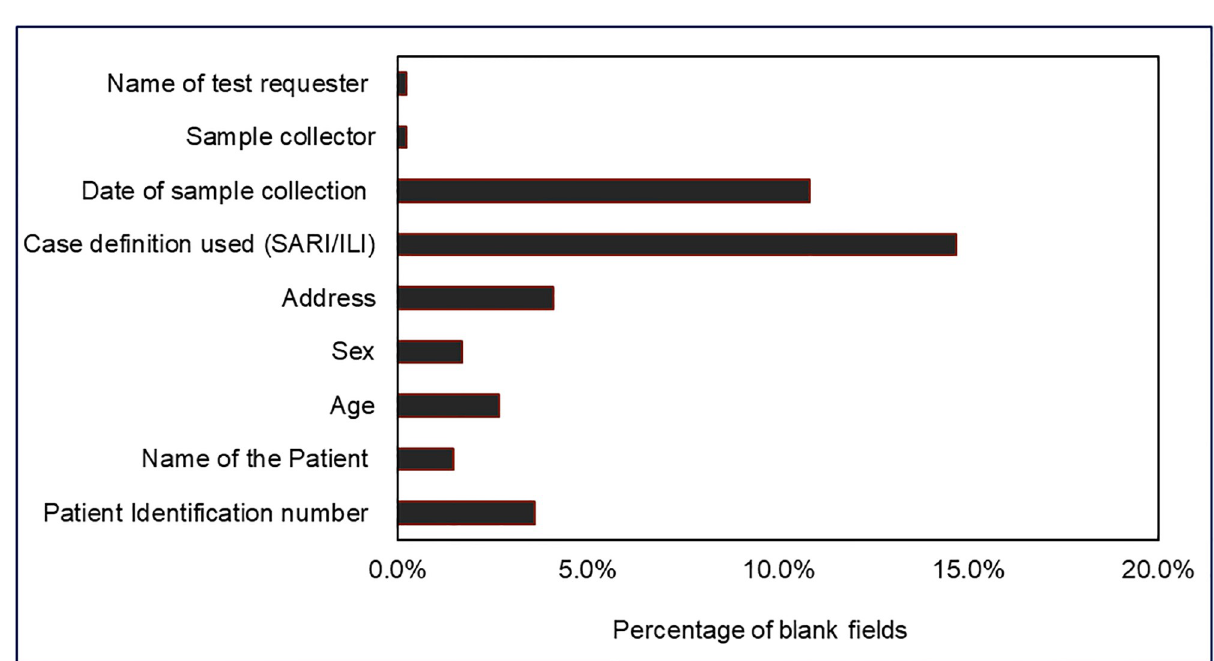
Fig 3. The proportion of incompleteness of selected parameters on influenza case-based forms used by the National Influenza Sentinel Surveillance System in Tanzania, 2019 (N = 415).